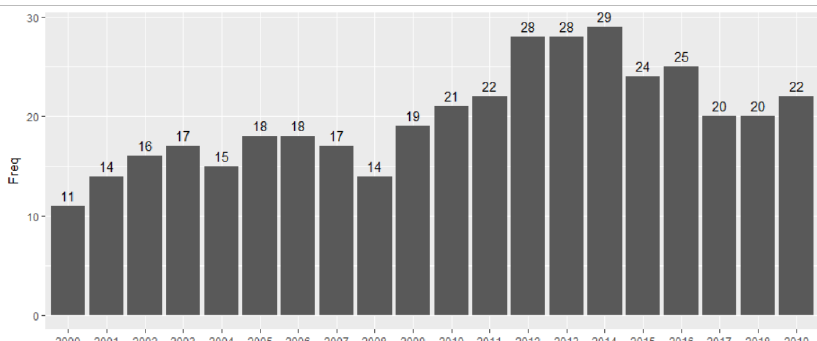
Figure 1. Number of economies in NES survey between 2000 and 2019.